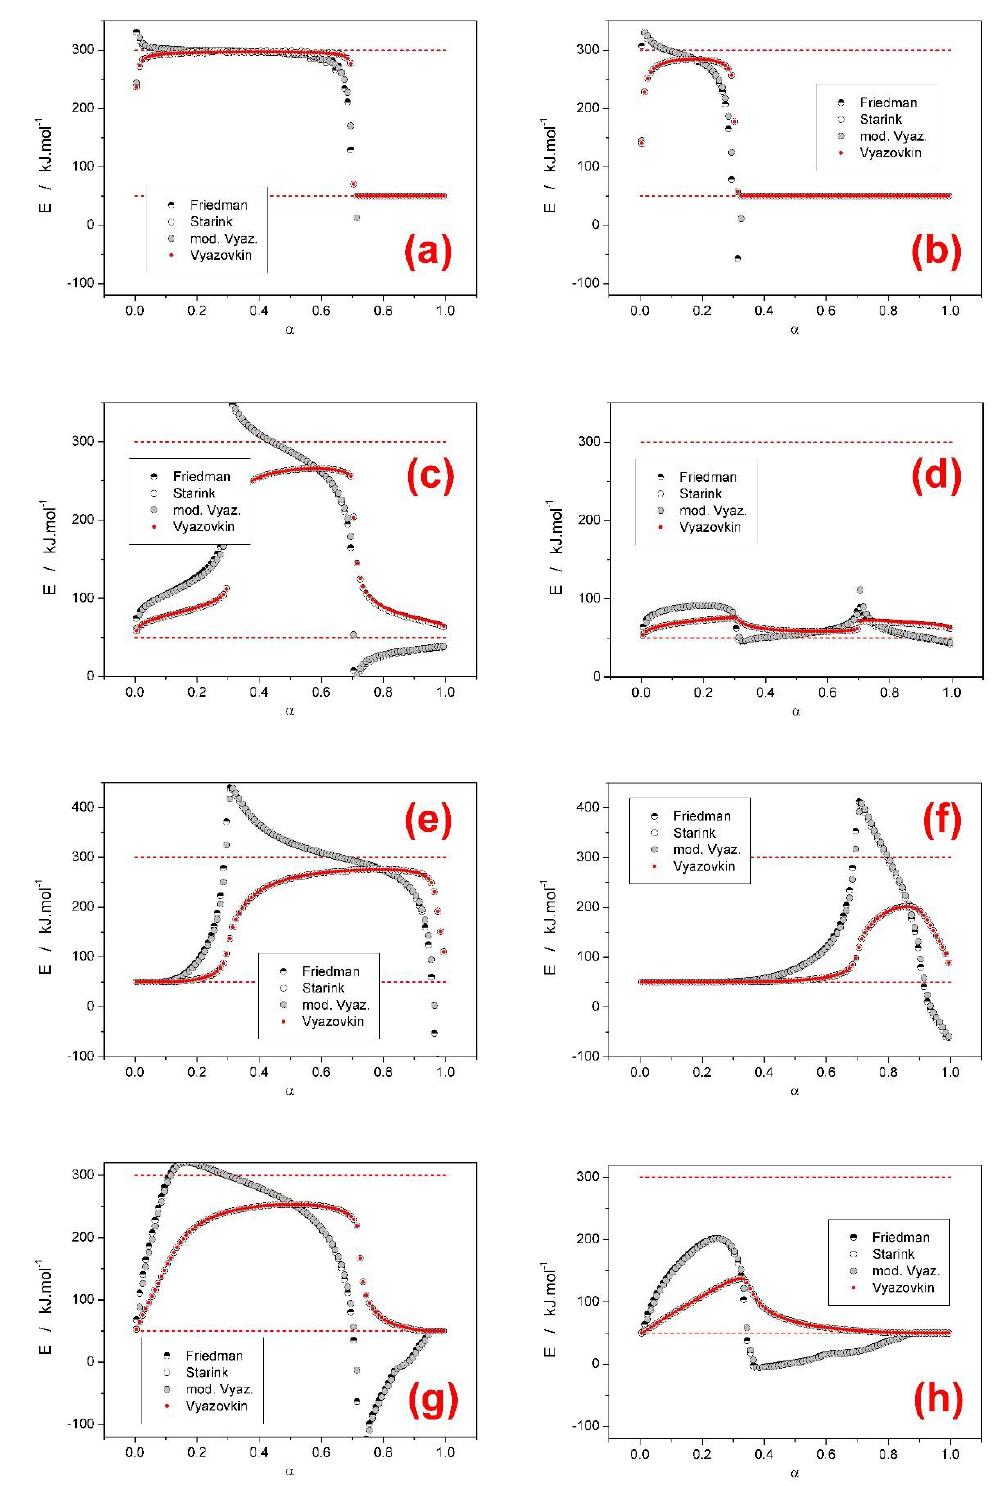
Figure 8. Results of the Friedman, Starink, Vyazovkin, and modified incremental Vyazovkin analyses applied to the datasets E–H (group 2) and the I 1 = 0.30, I 2 = 0.70, and I 1 = 0.70, I 2 = 0.30 simulated at 10,000 points / curve density. The horizontal red dashed lines in each graph represent the true E 1 and E 2 values input into the simulations. ( a ) set E, I 1 = 0.30, I 2 = 0.70; ( b ) set E, I 1 = 0.70, I 2 = 0.30; ( c ) set F, I 1 = 0.30, I 2 = 0.70; ( d ) set F, I 1 = 0.70, I 2 = 0.30; ( e ) set G, I 1 = 0.30, I 2 = 0.70; ( f ) set G, I 1 = 0.70, I 2 = 0.30; ( g ) set H, I 1 = 0.30, I 2 = 0.70; ( h ) set H, I 1 = 0.70, I 2 = 0.30.